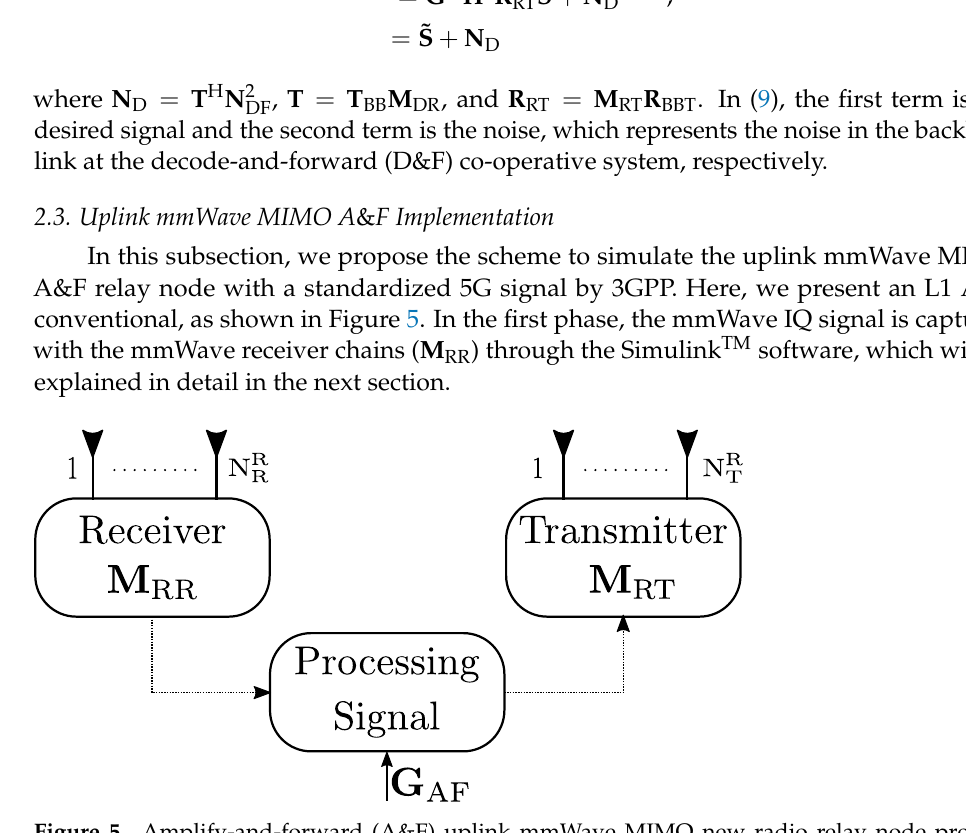
Figure 5. Amplify-and-forward (A&F) uplink mmWave MIMO new radio relay node process- ing